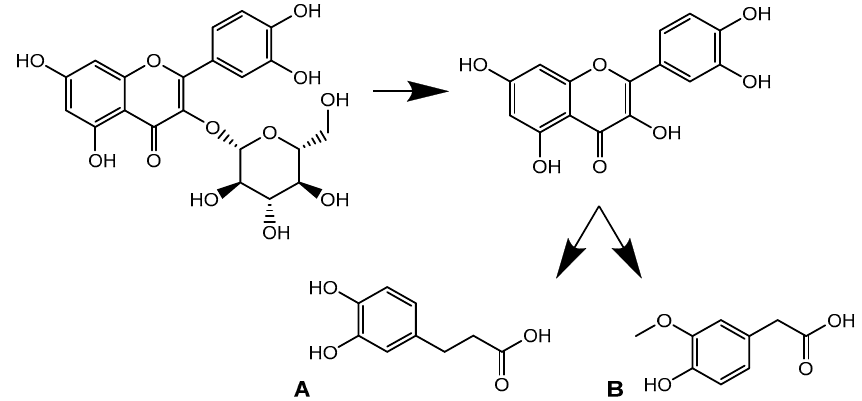
Figure 9. Biotransformation pathway of isoquercetin showing quercetin as intermediate metabolite which is further transformed into 3,4-dihydroxyphenylpropionic acid ( A ) or 3-methoxy-4- hydroxyphenylacetic acid ( B ).